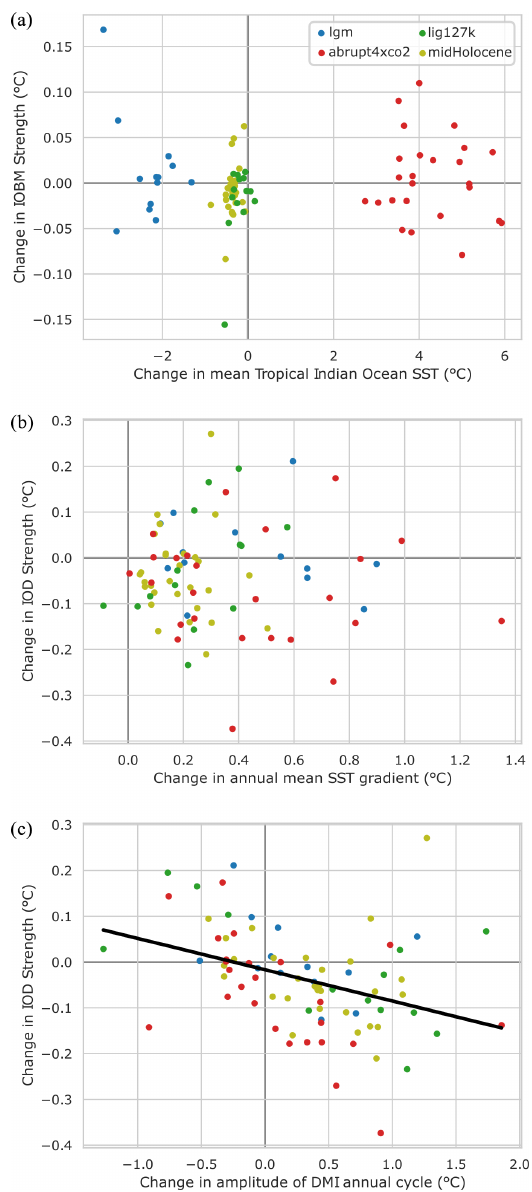
Figure 6. Relationships between the amplitude changes in modes of Indian Ocean variability and the mean state. (a) The strength of the Indian Ocean Basin Mode does not respond to changes in the tropi- cal Indian Ocean SST. (b) The strength of the Indian Ocean Dipole mode does not exhibit a simple linear relationship with annual mean changes in the zonal gradient. (c) Changes in IOD strength are con- nected with changes in seasonal cycle of the SST gradient, here represented as changes in the differences between the strongest and weakest monthly SST gradients. The black solid line indicates a statistically significant linear regression across the whole